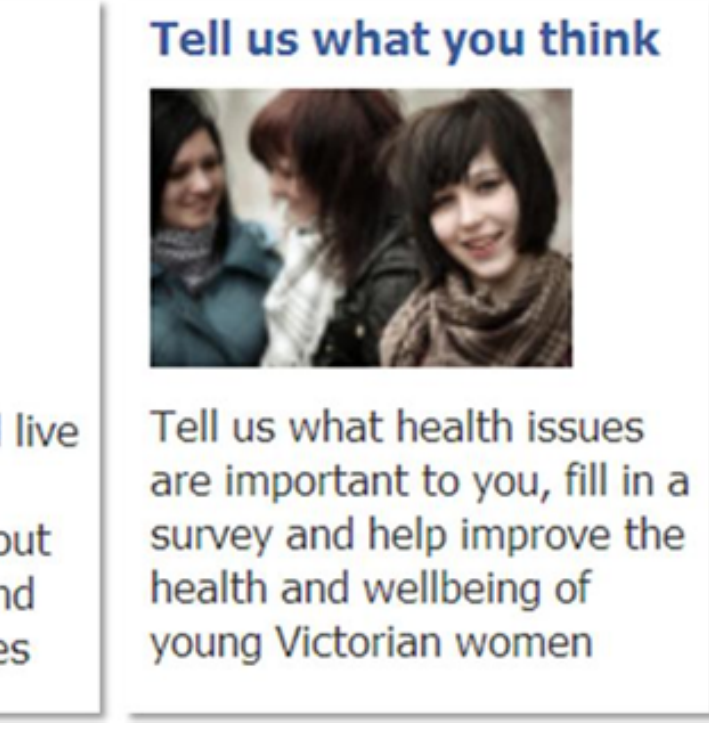
Figure 1. Examples of Facebook